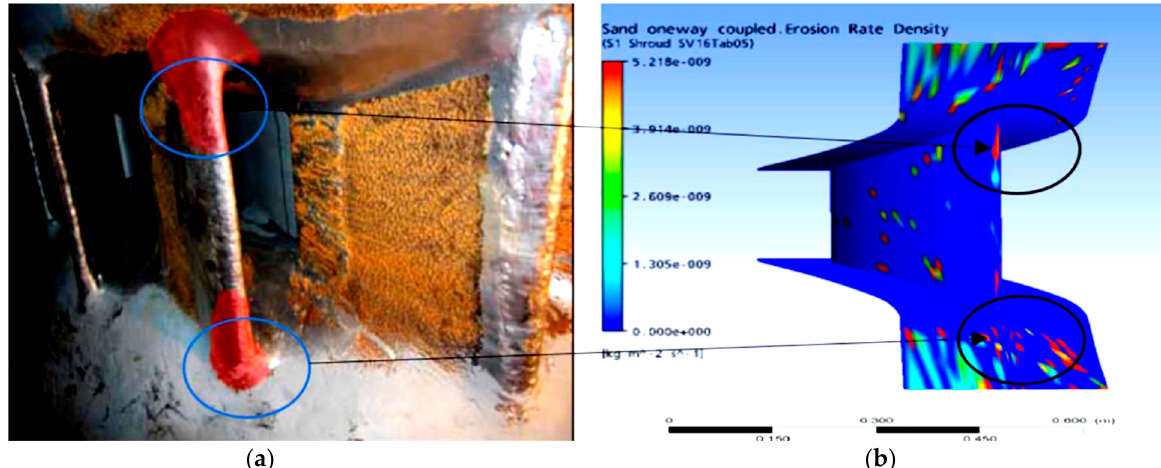
Figure 6. Guide vanes with covers, ( a ) at actual site, ( b ) erosion rate density profile [13].